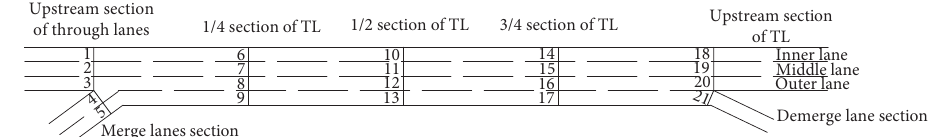
Figure 1: Location of data detection sections.